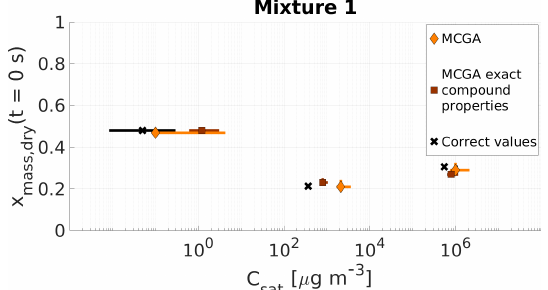
Figure 7. Parameter estimates for particles generated from mix- ture 1. Dry particle mass fraction at the start of the evaporation of three compounds and their saturation concentrations were opti- mized to match the evaporation data. Orange diamonds show the MCGA estimates calculated by assuming equal molar mass and particle-phase density for all compounds and brown squares show the MCGA estimates calculated by setting the molar mass and particle-phase density to their literature values. Black crosses show the literature values. The whiskers of the estimates show the 10th and 90th percentiles of the estimated variable distributions and the whiskers of the corrected values show the range of literature values (see Table 4 for references).